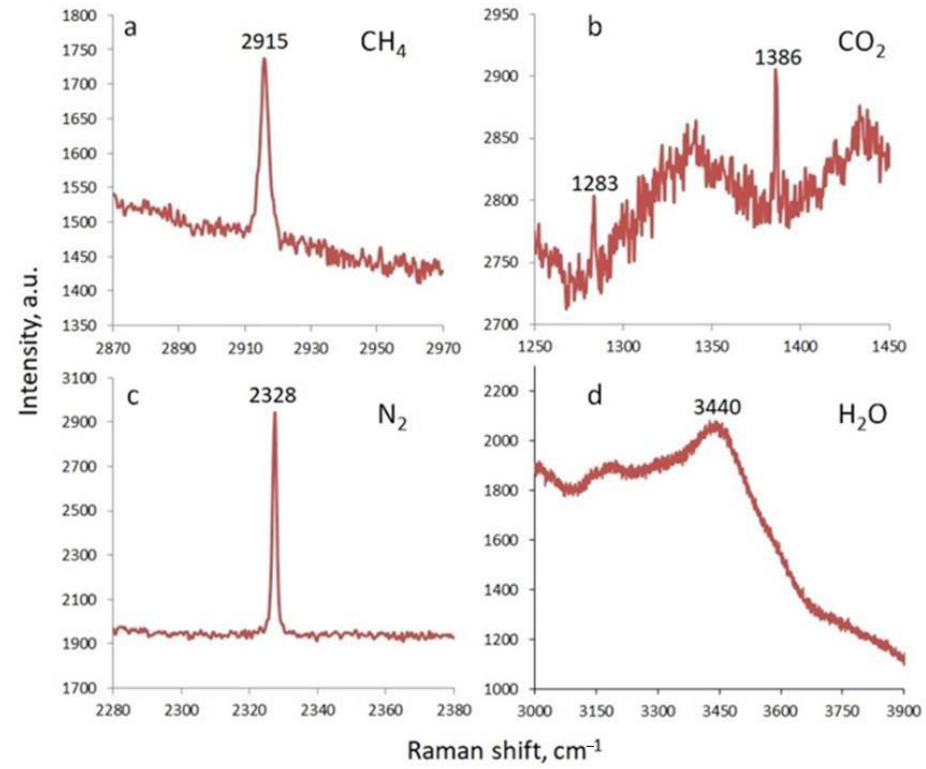
Figure 5. Raman spectra of the gas ( a – c ) and water ( d ) phases of fluid inclusions in quartz from the Dobroe deposit.